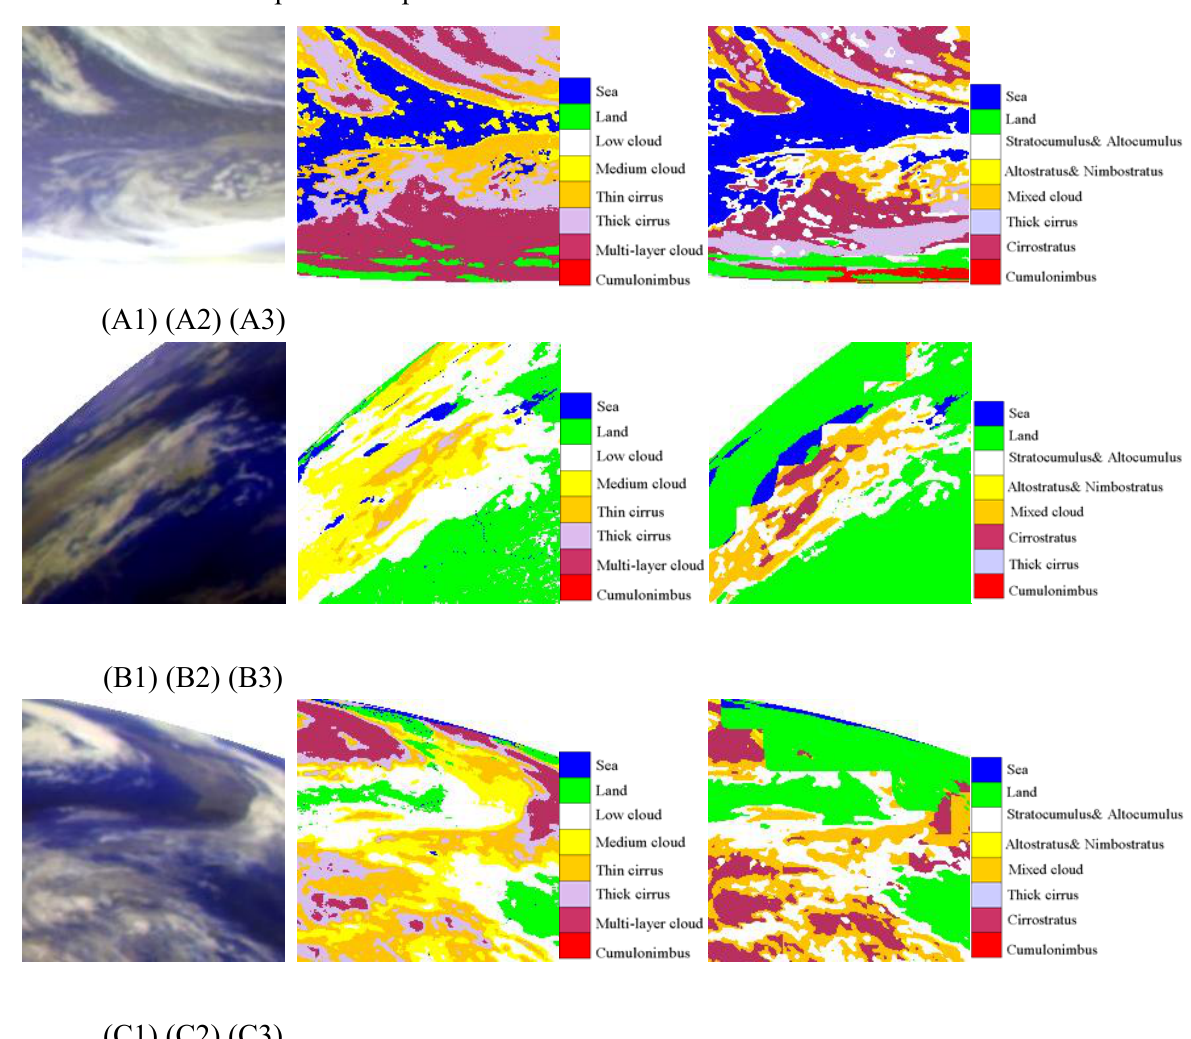
Figure 6. (A) The first line (A1, A2, A3) are high latitude cases at 07: 00 UTC (daytime); (B) The second line (B1, B2, B3) are high latitude cases at 15: 00 UTC (night); (C) the third line (C1, C2, C3) are high latitude cases at 23: 00 UTC (twilight); The first column (A1, B1, C1) are false RGB composite of Tbb of IR1, IR2 and WV; The second column (A2, B2, C2) are cloud classification results of ANN; The third column (A3, B3, C3) are results of FY-2C operational